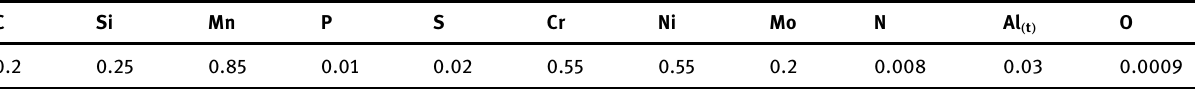
Table 1: Chemical composition of FAS3420H ( wt.% )